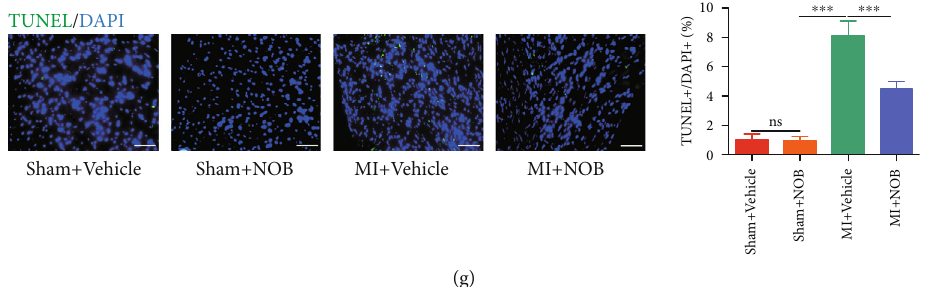
Figure 2: NOB mitigates pathological cardiac remodeling after MI. (a) Masson ’ s trichrome staining indicated that the fi brosis rate of the peri- infarct area descended signi fi cantly after NOB intervention (blue, fi brosis-positive area; red, fi brosis-negative area; scale bars: 50 μ m) ( n = 7 , 8, 6, and 8). (b) Western blot analysis revealed that collagen I and α -SMA were dramatically decreased in NOB intervention mice after MI ( n = 6 per group). (c) qRT-PCR analysis of collagen I and collagen III showed that NOB alleviated cardiac fi brosis after MI ( n = 6 per group). (d) qRT-PCR analysis showed that NOB alleviated the upregulation of ANP and BNP induced by MI ( n = 6 per group). (e) HE staining revealed that the cross-sectional areas of cardiomyocytes were smaller in the intervention group than in the MI group (scale bars: 50 μ m, n = 7 , 8, 6, and 8). WGA staining illuminated the same trends as HE staining: the increased cross-sectional areas of cardiomyocytes were smaller after NOB intervention (scale bars: 20 μ m, n = 3 per group). (f) Western blot showed that the ratio of Bax/Bcl2 and the expression of cleaved caspase-3 were both lower in the NOB intervention group than in the MI group ( n = 6 per group for Bax/Bcl2 and n = 3 per group for cleaved caspase-3). (g) TUNEL staining displayed that the upregulated apoptotic-positive cardiomyocyte rate was decreased after NOB intervention in cardiac tissue (blue: nuclei; green: apoptotic-positive nuclei; scale bars: 100 μ m, n = 3 per group). Data are presented as mean ± SD . ∗ P < 0 : 05 ; ∗∗ P < 0 : 01 ; ∗∗∗ P < 0 : 001 ; ns P > 0 : 05 . NOB: nobiletin; MI: myocardial infarction; ANP: natriuretic peptide type A; BNP: natriuretic peptide B; HE staining: haematoxylin and eosin staining; WGA staining: wheat germ agglutinin;